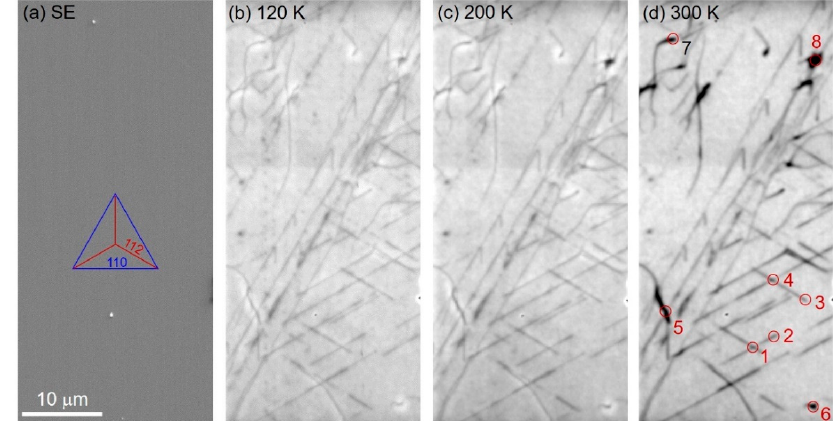
Figure 1. SE and temperature-dependent electron-beam-induced current (EBIC) images of dislocations in (111) SrTiO 3 . ( a ) SE; ( b ) EBIC 120 K; ( c ) EBIC 200 K; ( d ) EBIC 300 K. Site 1–4 are dislocations slips and site 5–8 are tangled dislocations.